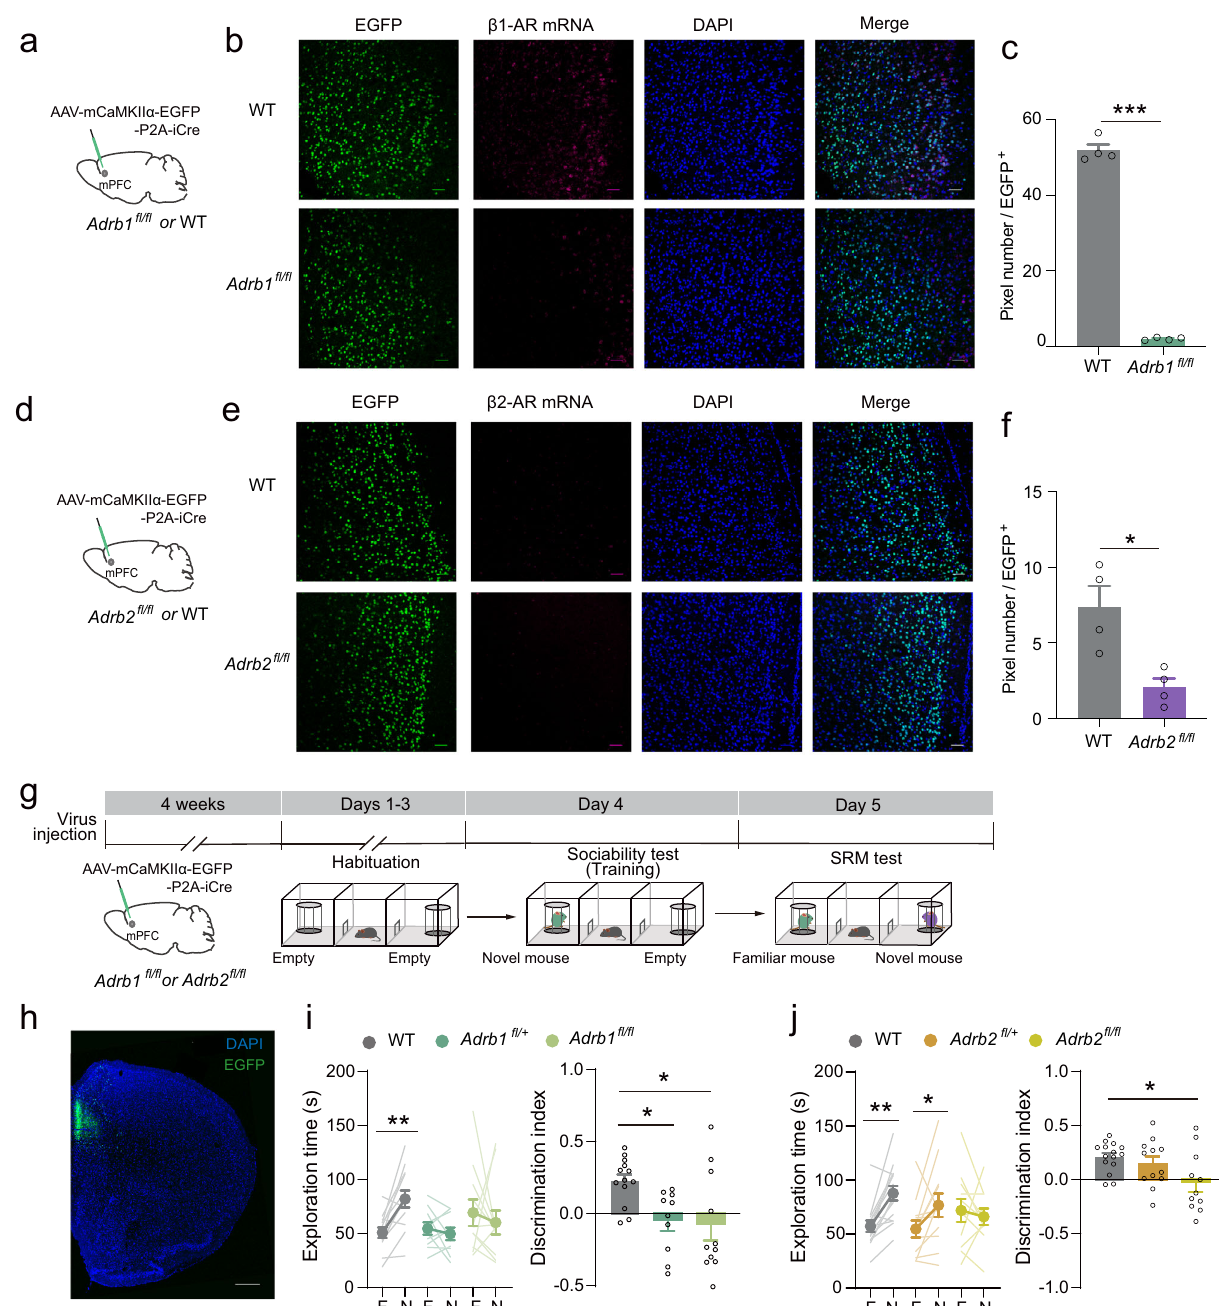
Fig. 2 β -AR signaling in the mPFC mediates SRM consolidation. a , d AAV 9 -mCaMKII α -EGFP-P2A-iCre was injected in the mPFC of Adrb1 fl / fl or Adrb2 fl / fl mice and their WT littermates. b , e , c , f Representative images and statistical graphs of the adrb1 and adrb2 mRNA levels in the mPFC by FISH. [ c WT: n = 4 (3729 cells), Adrb1 fl / fl : n = 4 (3503 cells), t (6) = 31.54, p < 0.001, two-tailed Student ’ s t test; f WT: n = 4 (3192 cells), Adrb2 fl / fl : n = 4 (3538 cells), t (6) = 3.543, p = 0.012, two-tailed Student ’ s t test]. Scale bar: 50 μ m. g Experimental scheme. AAV 9 -mCaMKII α -EGFP-P2A-iCre was injected in the mPFC of Adrb1 fl / fl or Adrb2 fl / fl mice and their WT and heterozygote littermates. Four weeks later, SRM task was performed. h Representative image of Cre-EGFP expression in the mPFC. Scale bar: 500 μ m. i , j Statistical graphs of exploration time for the familiar (F) and novel (N) mice and discrimination scores of the mice with Adrb1 or Adrb2 knockout in the mPFC. [ i WT: n = 13, Adrb1 fl / + : n = 10, Adrb1 fl / fl : n = 11. F mouse × genotype (2, 31) = 4.085, p = 0.027, two-way RM ANOVA; Right: F (2, 31) = 5.364, p = 0.01, one-way ANOVA. j WT: n = 15, Adrb2 fl / + : n = 12, Adrb2 fl / fl : n = 11. Left: F mouse × genotype (2, 35) = 4.433, p = 0.019, two-way RM ANOVA, Right: F (2, 35) = 4.139, p = 0.024, one-way ANOVA]. * p < 0.05, ** p < 0.01 and *** p < 0.001 vs indicated